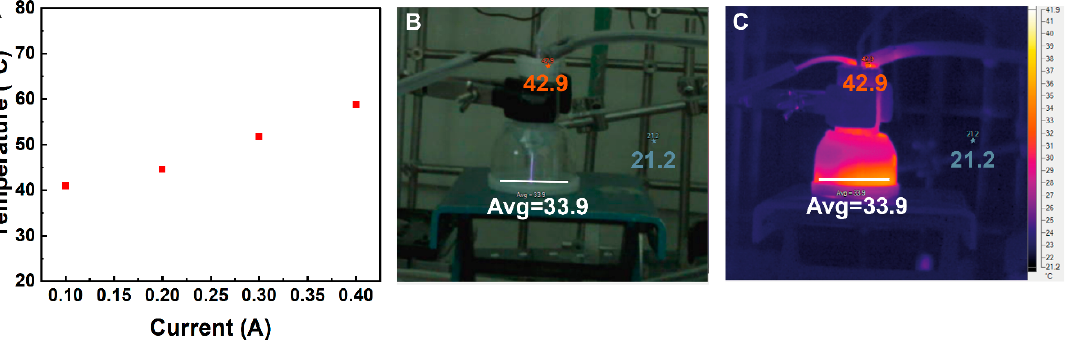
Figure 2. ( A ) Plasma jet contact point temperature on a glass surface as a function of plasma generator current ( B ) plasma jet contact with the surface and ( C ) the resulting average temperature at the surface as measured by a thermal imager.